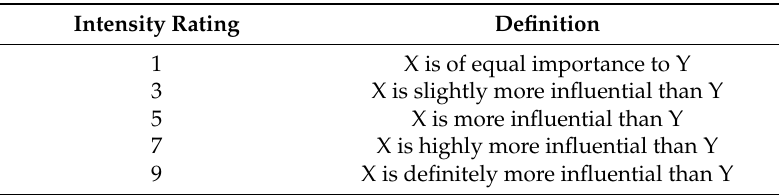
Table 1. Pairwise comparison decision importance